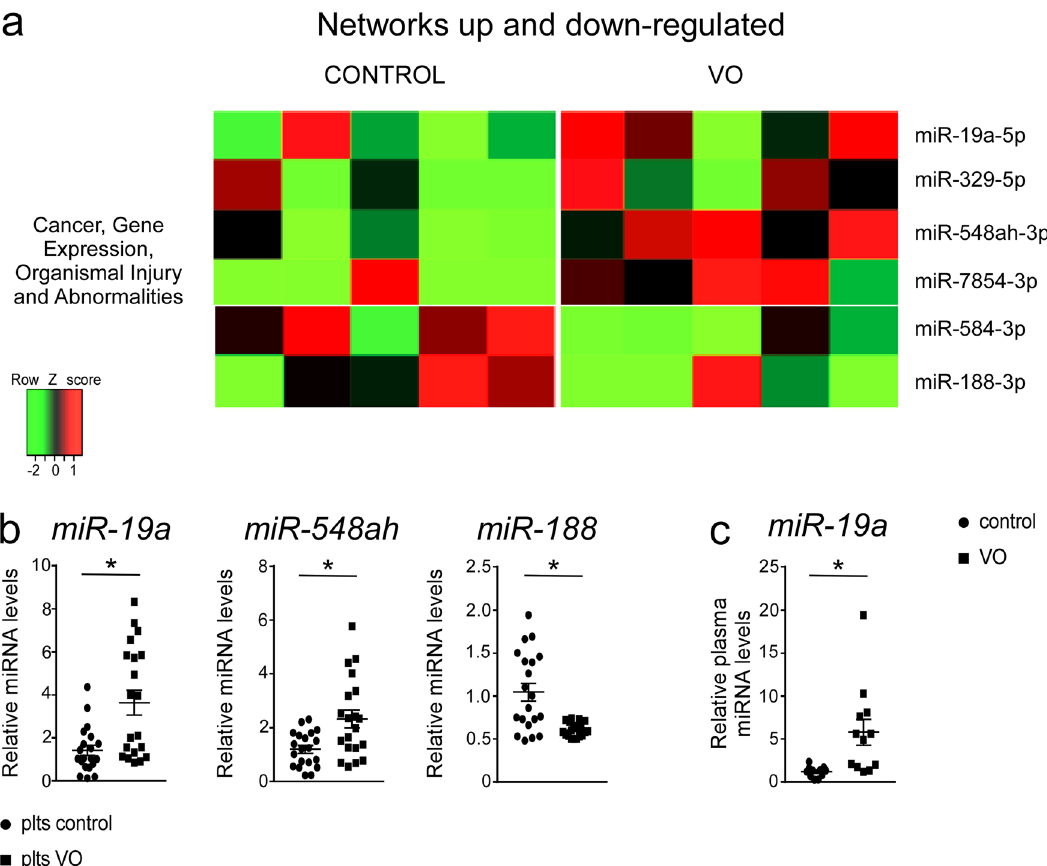
Fig. 2 Identi fi cation of miRNome pro fi le in platelets isolated from VO patients. a miRNAs up and down-regulated in platelets isolated from VO patients and controls were pro fi led using sequencing, and clustered in networks displaying a coordinate biological function. Data are shown in a heatmap with a matrix format of the miRNA differentially modulated within the network; single rows represent miRNA expression in a single patient (column). Colors: red, expression greater than the mean; black, expression equal to the mean; green, expression smaller than the mean ( n = 5 samples/group). b Relative miR- 19a , miR-548ah and miR-188 expression from platelets of VO patients and controls ( n = 20 samples/group). c Relative plasma miR-19a expression from VO patients and controls ( n = 12 samples/group). The data were normalized on the geometric mean (best-keeper gene) of miR-374 and RNU6B , presented as relative expression values. All results are shown as means ± SEM in scatter plots. Statistical signi fi cance ( P < 0.05) was assessed by student ’ s t